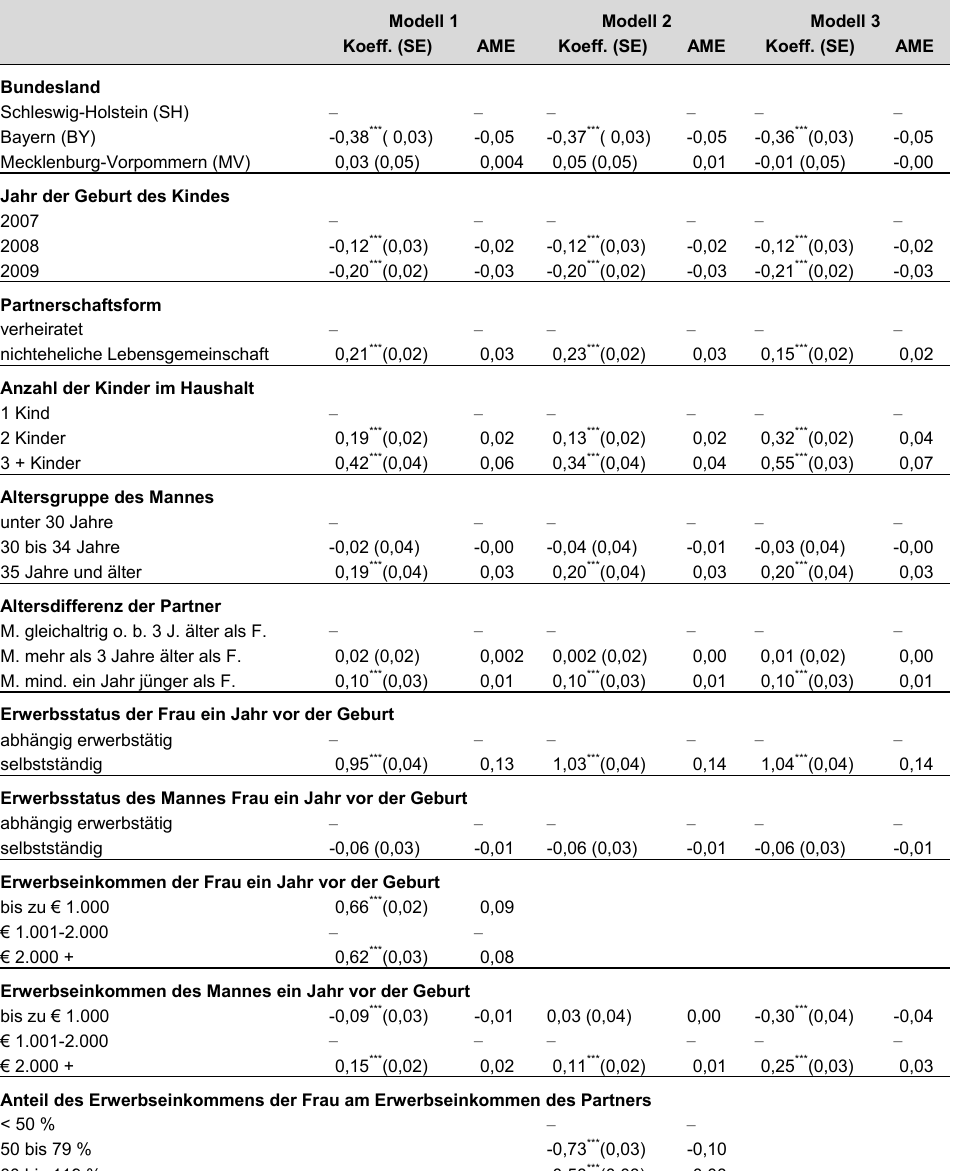
Tabelle 3 : Determinanten eines mehr als zweimonatigen Elterngeldbezugs